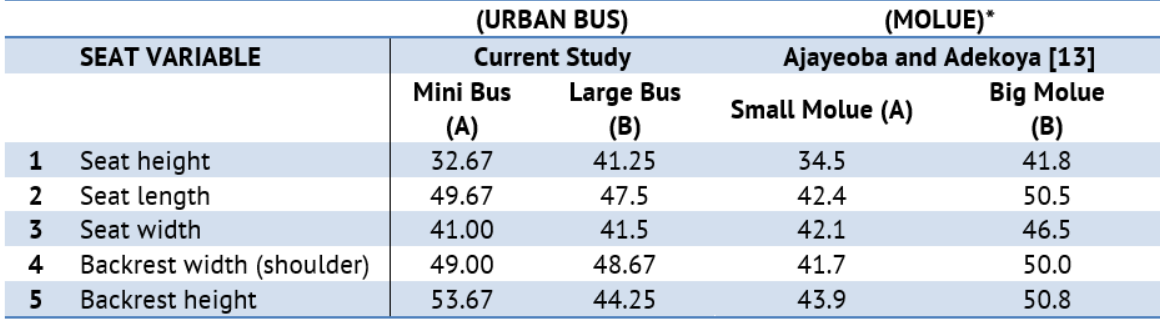
Comparison of Seat Data in this study with those in a related